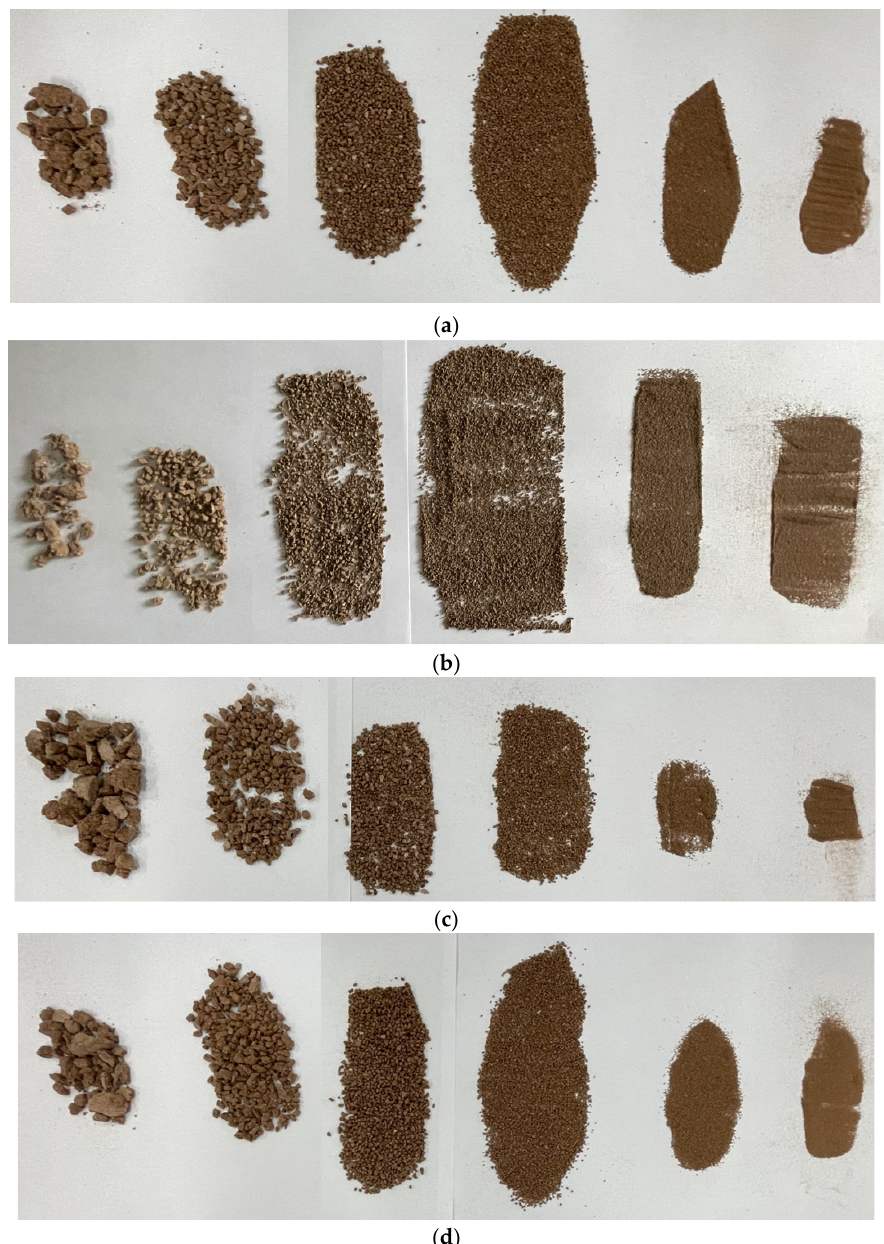
Figure 13. Crushing particle size under different test conditions. ( a ) Freeze–thaw cycle: 0, 0.10 MPa; ( b ) Freeze–thaw cycle: 10, 0.10 MPa; ( c ) Freeze–thaw cycle: 1, 0.08 MPa; ( d ) Freeze–thaw cycle: 1, 0.12